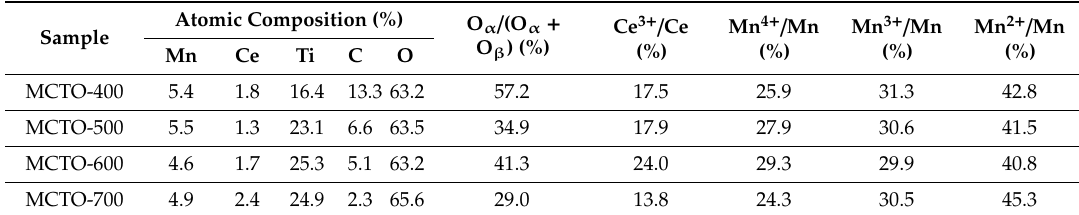
Table 3. Surface atomic compositions of catalysts measured by